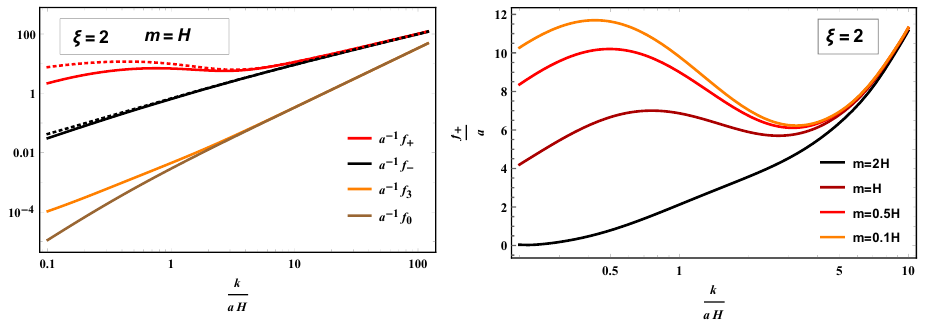
for ξ = 2 . Left panel shows the aH , f − , f 3 , f 0 ) with m = H . The dotted lines shows the a a a a